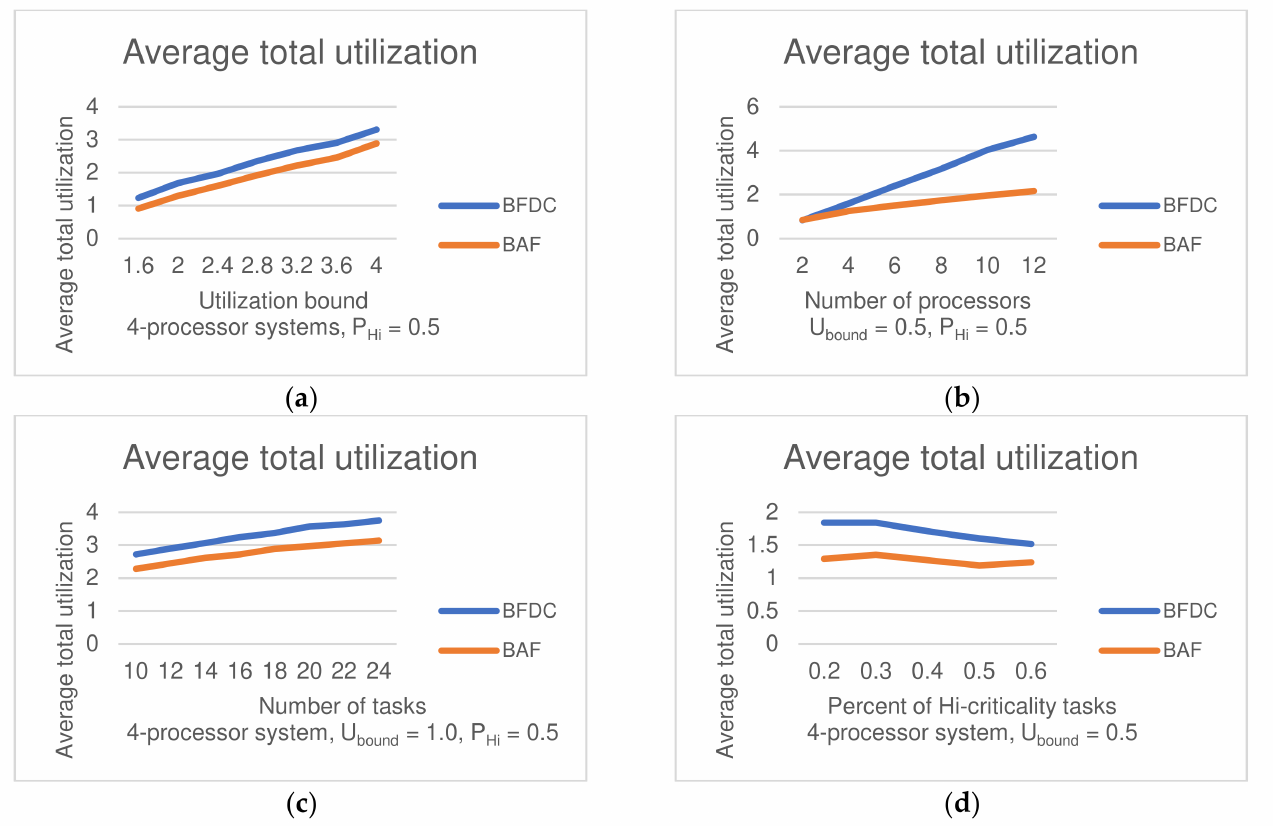
Figure 4. Average total processor utilization by varying: ( a ). the utilization bound, ( b ). the number of processors, ( c ). the number of tasks, ( d ). the percentage of Hi-criticality tasks. U L = 0.05, U U = 0.75, Z L = 1, Z U = 8.